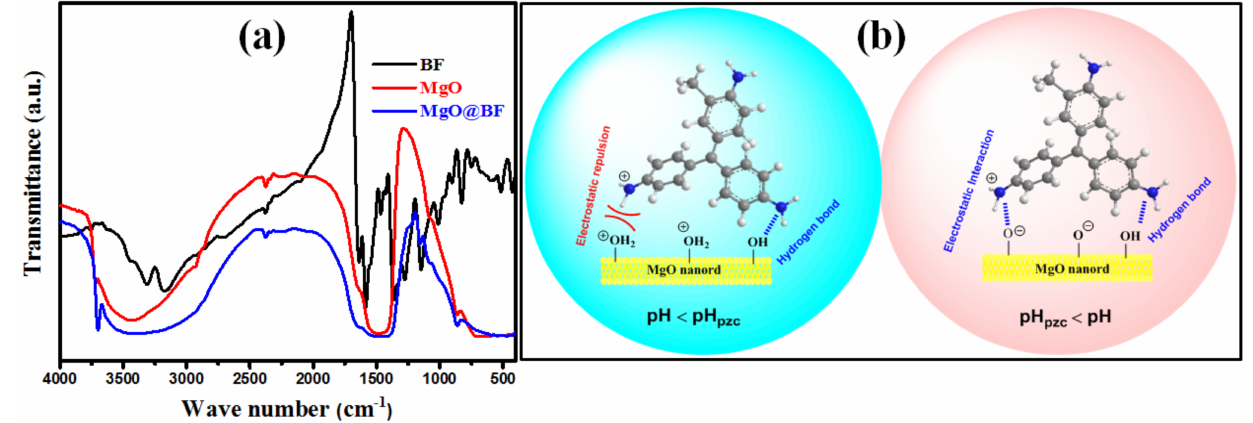
Figure 7. ( a ) FTIR spectra of MgO, BF, and MgO@BF and ( b ) the proposed adsorption mechanism of BF onto MgO